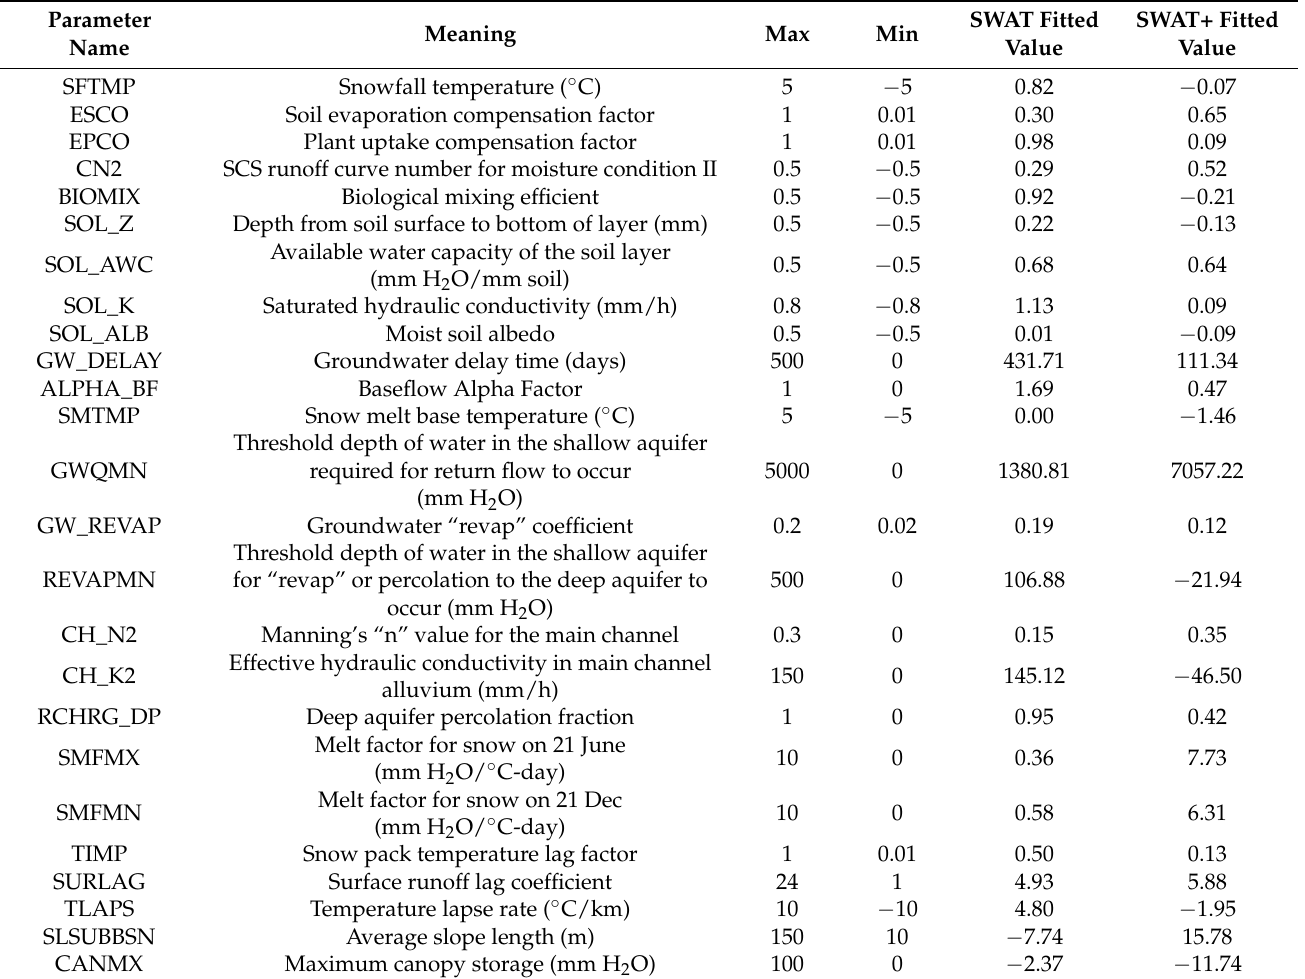
Table 1. Parameters for SWAT and